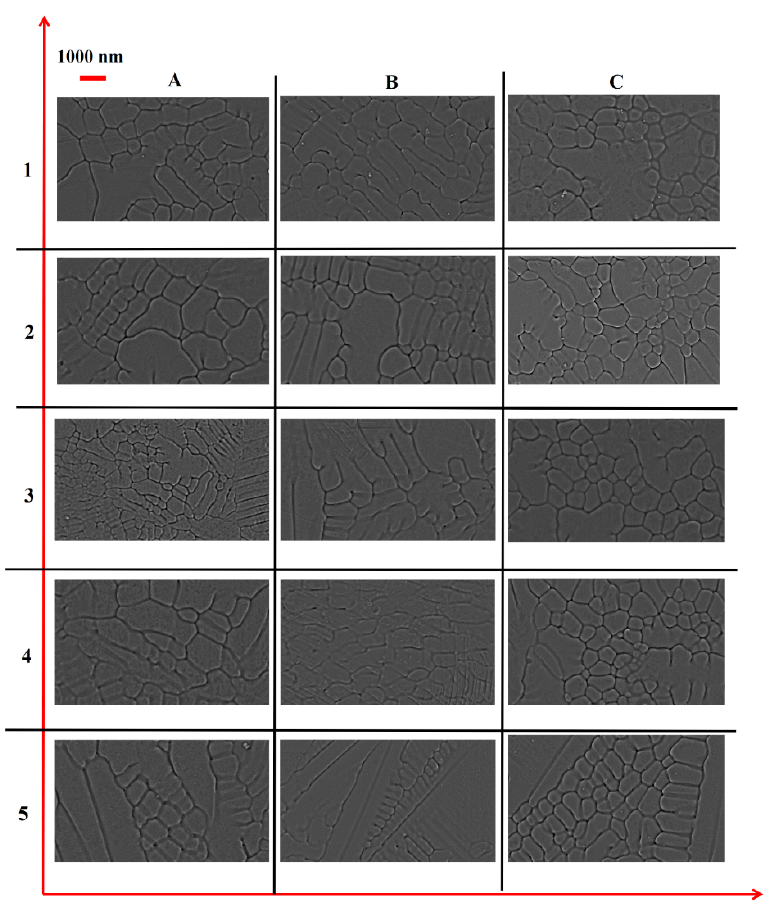
Figure 9. SEM images of A1–A5 (1st column), B1–B5 (2nd column), and C1–C5 (3rd column) samples.